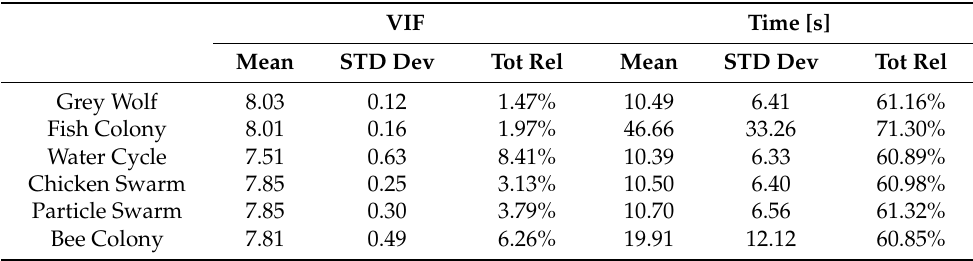
Table 6. Comparison of swarm intelligence algorithms analyzed in terms of VIF and computational time for linear